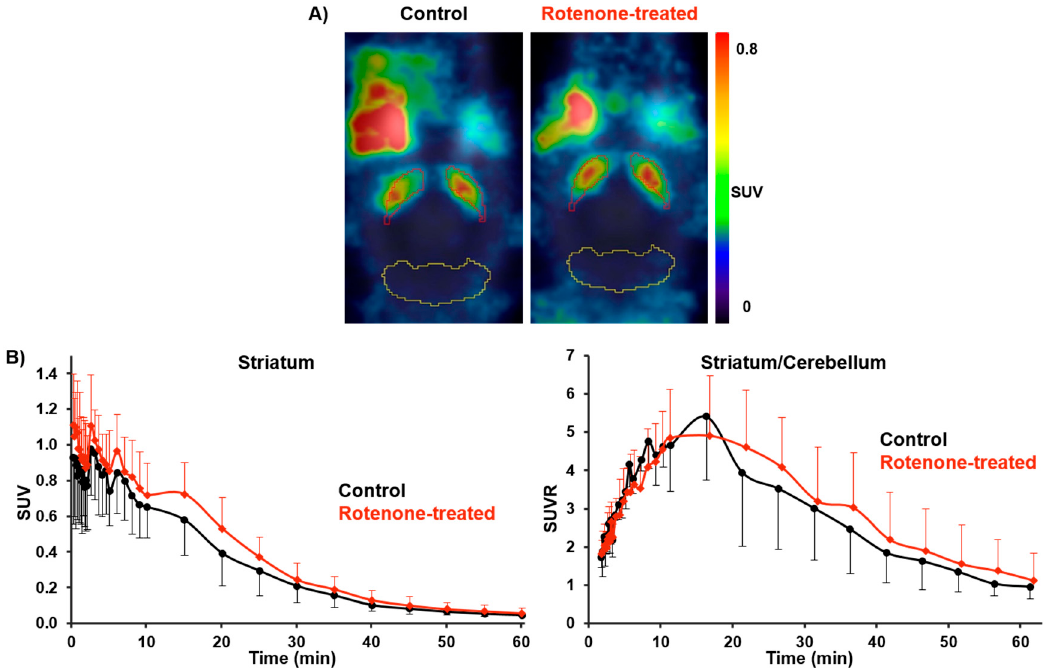
Figure 6. ( A ) Representative horizontal PET images of [ 18 F] FESCH uptake (average 2–61 min) in the brain of control and rotenone-treated C57BL/6JRj mice (red = striatum; yellow = cerebellum). ( B ) Averaged TACs of [ 18 F] FESCH for control (n = 5) and rotenone-treated mice (n = 7) with SUVs for striatum and SUVRs for striatum over cerebellum.